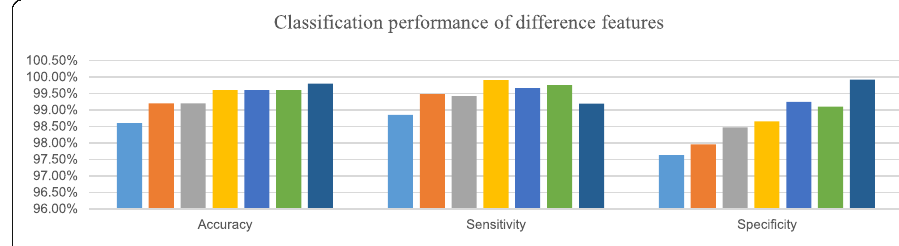
Fig. 9 The performances of different